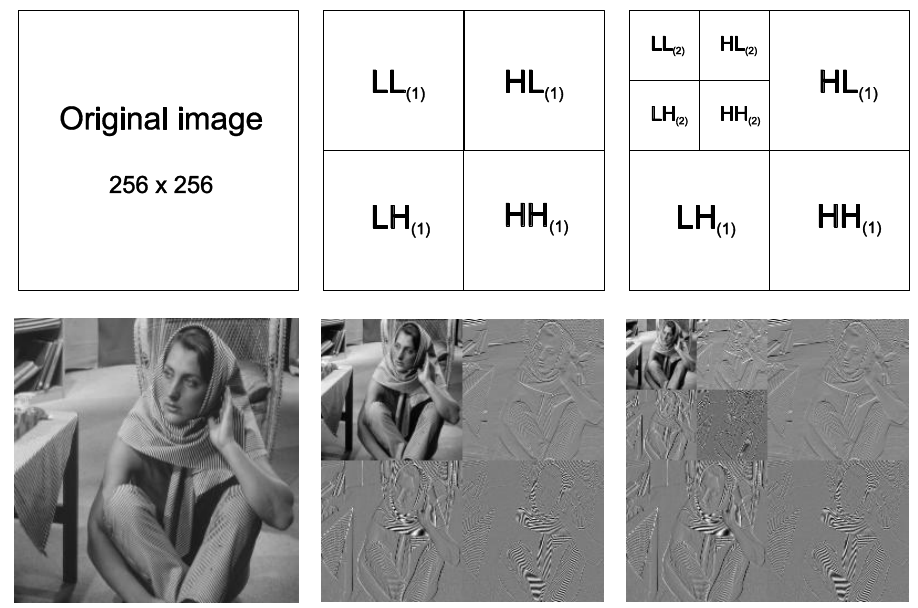
Figure 3. Discrete Wavelet Transform (DWT) processing generating two and three levels of